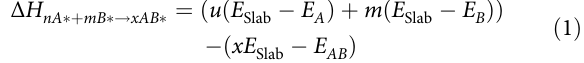
Fig. 1 Structure sensitivity and support effects for tuning selectivity and activity in the carbon dioxide hydrogenation over Ni. a – c The particle size dependence of the turn over frequency (TOF) for CO 2 hydrogenation towards methane, ethane, and CO over SiO 2 -supported Ni catalysts at 5 bar, with varying temperatures and at 400°C, with varying pressures. d The support dependence of CO 2 hydrogenation as measured by operando FT-IR spectroscopy from 100 to 400 °C with corresponding yield (measured in a high-throughput reactor system, corresponding well to online values for operando FT-IR spectroscopy) at 300 °C. e TOF of CO 2 methanation at 400 °C plotted against the wavenumber at which the maximum absorbance is observed in the CO region (2200 – 1800 cm − 1 ). Error bars in e and f are de fi ned as standard deviation in particle size in TOF calculation. f TOF of CO 2 methanation at 400°C plotted against the wavenumber at which the maximum absorbance is observed in the formate region (1550 – 1600 cm − 1 ) for catalysts showing comparable wavenumber of maximum absorbance in the CO ads region (range: 2019 – 2023 cm − 1 ). The ranges indicated in blue in the plot are the calculated fundamental vibrational frequencies of each most stable adsorbate (of HCO 2 * and HCO*) on Ni(111), with a 5% error bar indicated on the top of the fi gure. g Apparent activation energy barriers calculated from operando FT-IR measurements at different temperatures, for the different